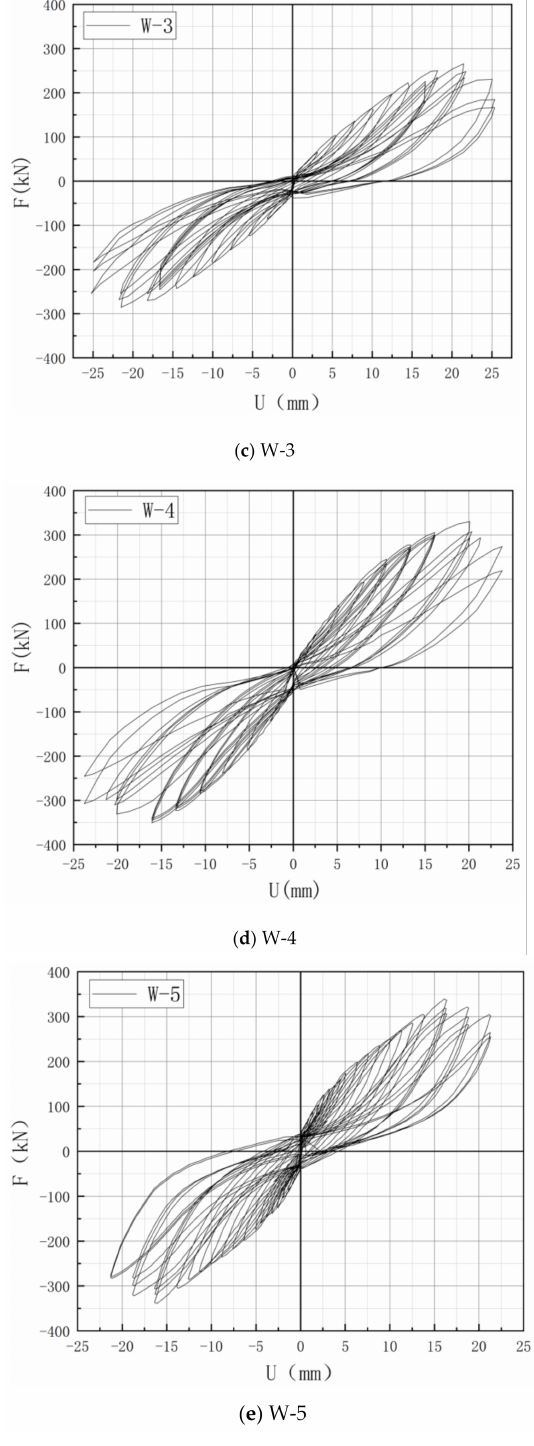
Figure 8. Hysteresis loops of